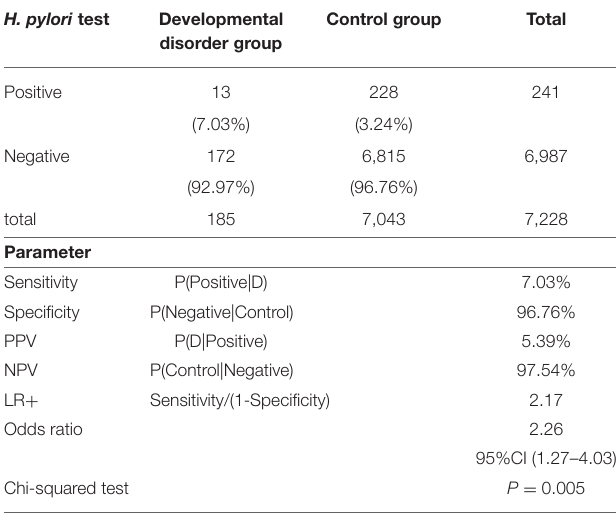
TABLE 1 | Test for Helicobacter pylori infection rate between the control group and developmental disorders group. H. pylori